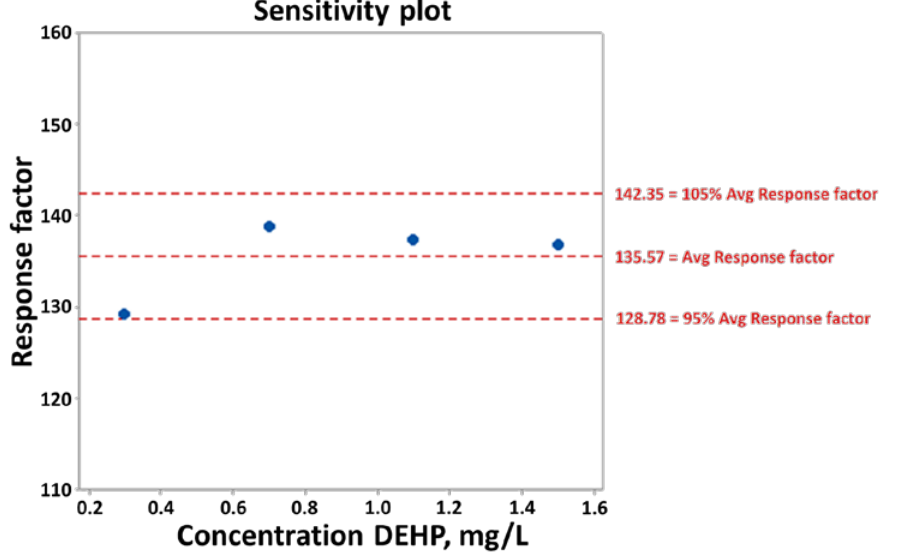
Figure 7. Sensitivity plot for the linearity check of the method.